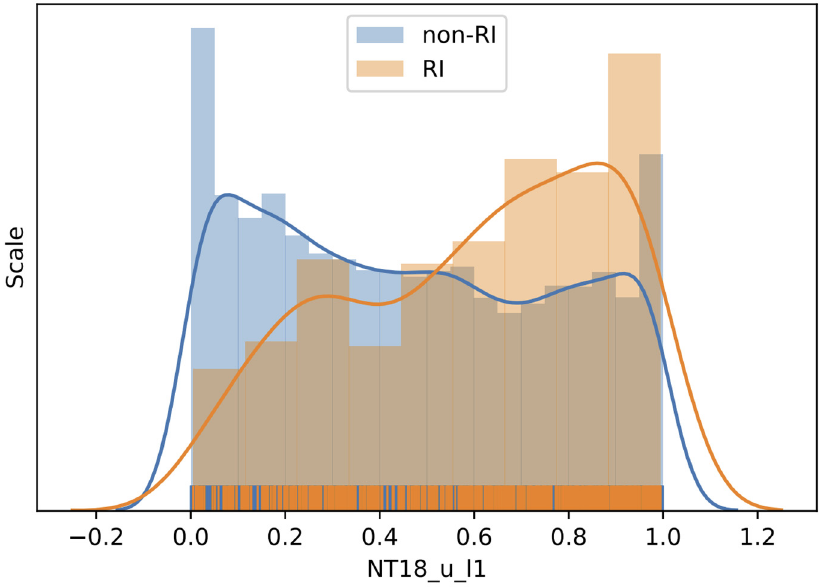
Figure 4. Same as Figure 2 but for variable NT18_u_l1 (zonal wind speed 18 h before current time at 1000 hPa).